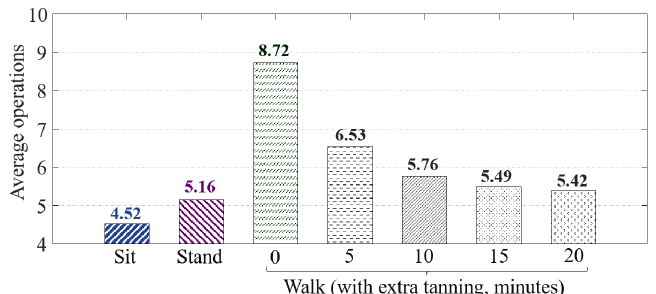
Figure 12. The average operation required for our system to log out attackers in the scenario of user sitting, standing and walking.